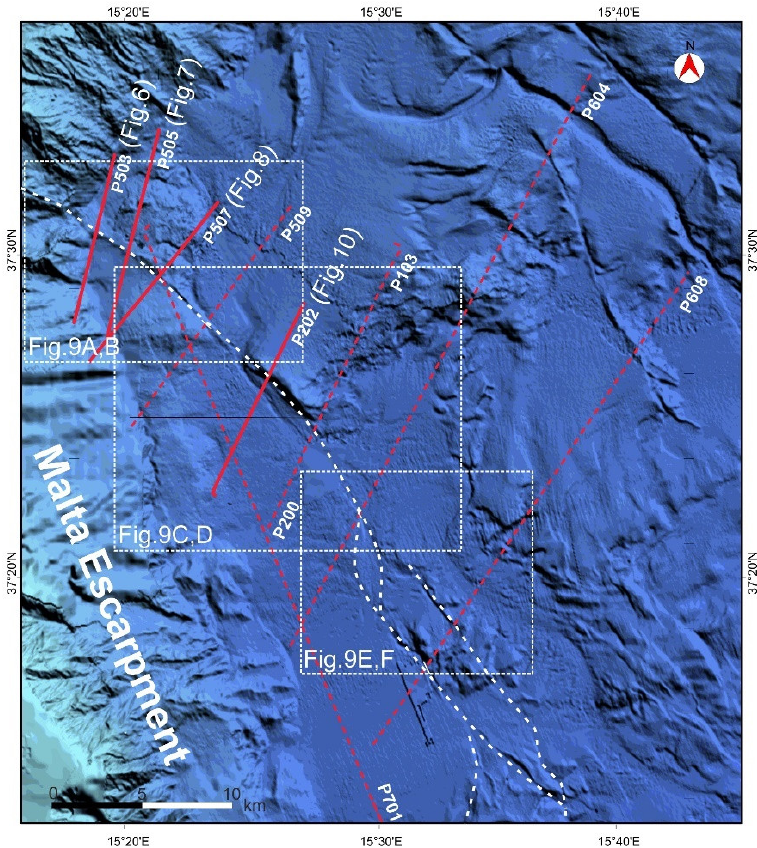
Figure 5. Seismic grid of the Poseidon expedition POS496 [75] in the Catania–Siracusa offshore (see location in Figure 1). Solid red lines are the profiles discussed in the text. The white dashed line is the trace of the North Alfeo Fault (from [10]).